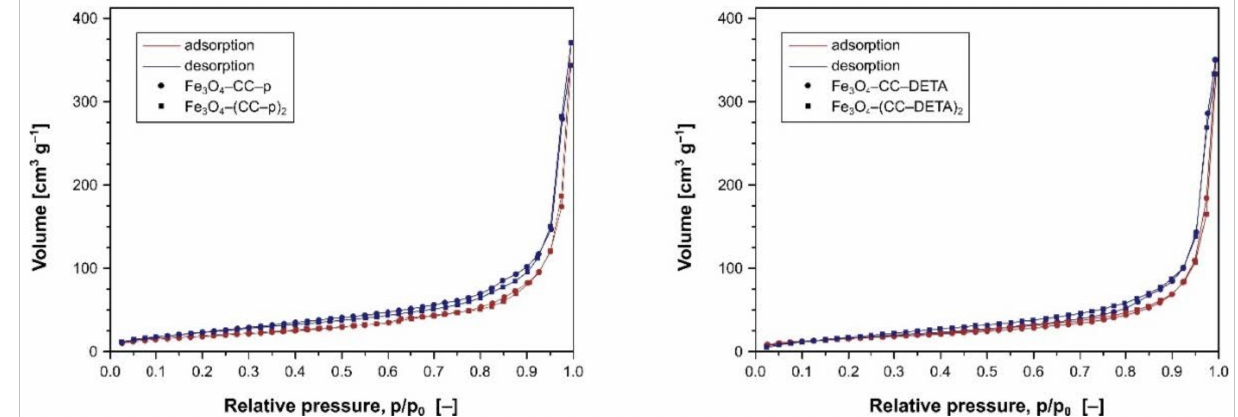
Figure 4. The BET isotherms of the materials containing piperazine-dendrons ( left ) and DETA-dendrons ( right ).